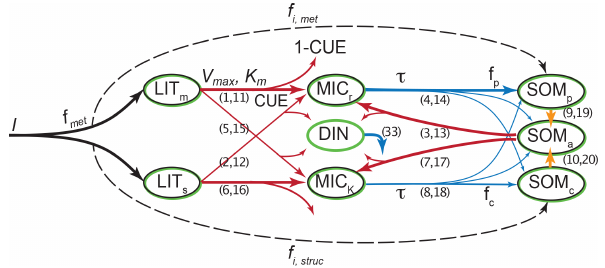
Figure 1. Overview of the pools and fluxes of C and N in MIMICS- CN. Black outlines indicate pools that contain C; green outlines in- dicate pools that contain N. Litter inputs ( I ) are determined based on site-specific net primary productivity and partitioned between metabolic and structural litter pools (LIT m and LIT s ) using a site- specific litter quality metric ( f met ) calculated using litter lignin and N content. Temperature-sensitive forward Michaelis–Menten kinet- ics ( V max and K m ; red lines) determine the flux of litter pool C and N and available SOM C and N (SOM a ) into microbial biomass (MIC r and MIC K ). Fluxes of C into microbial pools result in res- piration losses according to a defined carbon use efficiency (CUE). Microbes maintain biomass stoichiometry by spilling excess C as overflow respiration or excess N into the dissolved inorganic ni- trogen pool (DIN) based on a prescribed biomass C:N. Microbial biomass turnover ( τ , blue) varies by functional type (MIC r and MIC K ) and is proportional to the square of microbial biomass. Mi- crobial biomass turns over into available (SOM a ), physicochemi- cally stabilized (SOM p ), and chemically stabilized (SOM c ) soil or- ganic matter pools. Inorganic N (DIN) leaks from the model at a first-order rate. Numbers in parentheses indicate the equations in Appendix A that correspond to each depicted flux. Parameter val- ues, units, and descriptions are given in Table